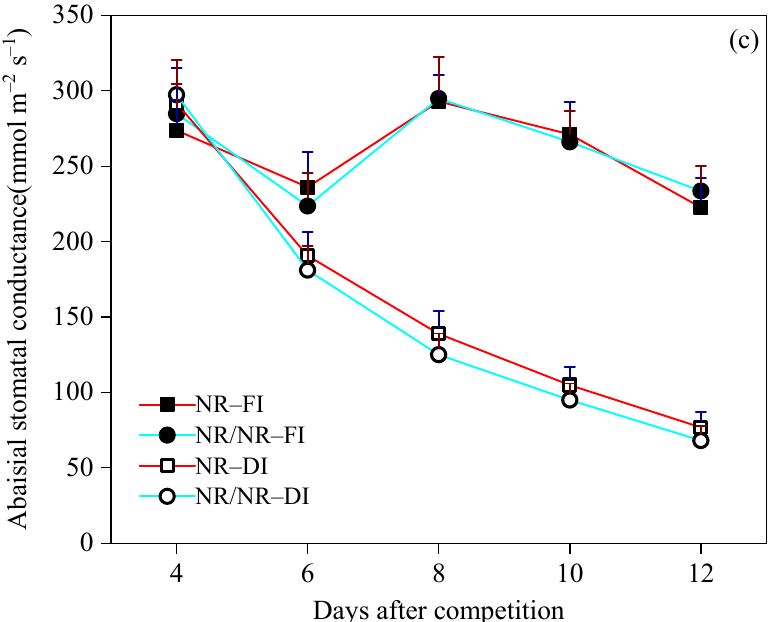
Figure 4. Variation of leaf area ( a ), transpiration ( b ), and abaxial stomatal conductance ( c ) of the single and competing plant of NR tomato under full irrigation and deficit irrigation (* p < 0.05).